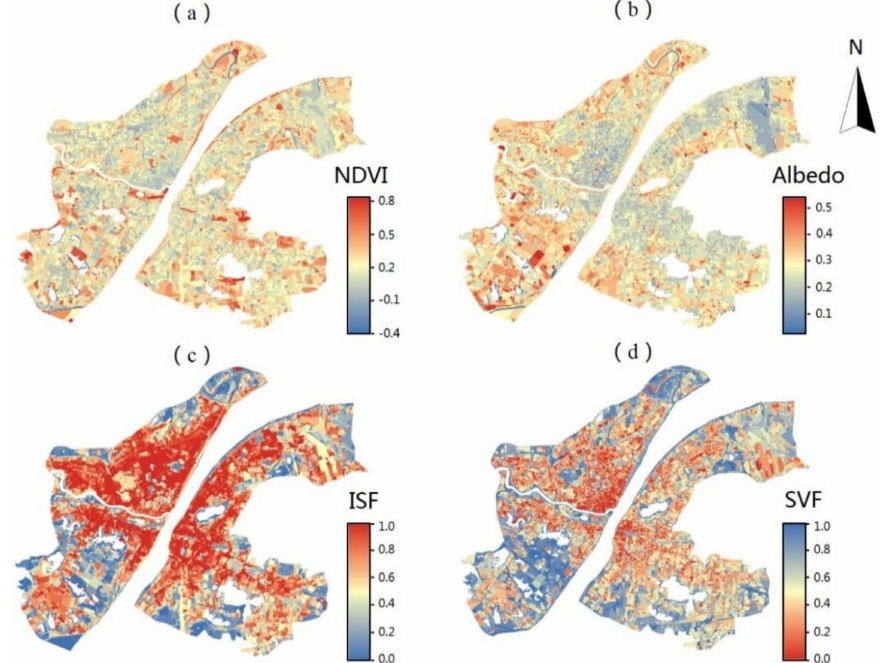
Figure 5. The spatial distributions of the selected indicators. ( a ) normalized di ff erence vegetation index (NDVI); ( b ) Albedo; ( c ) impervious surface fraction (ISF); ( d ) sky view factor